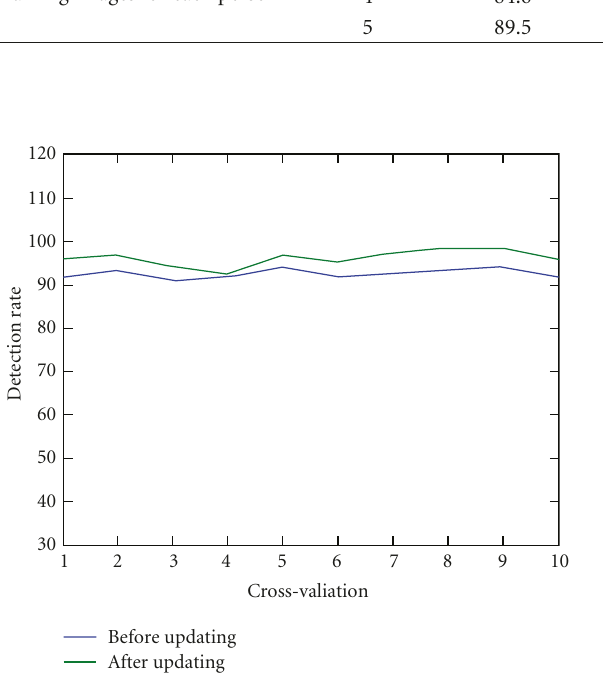
Figure 20: The threshold distinguishing the clients and